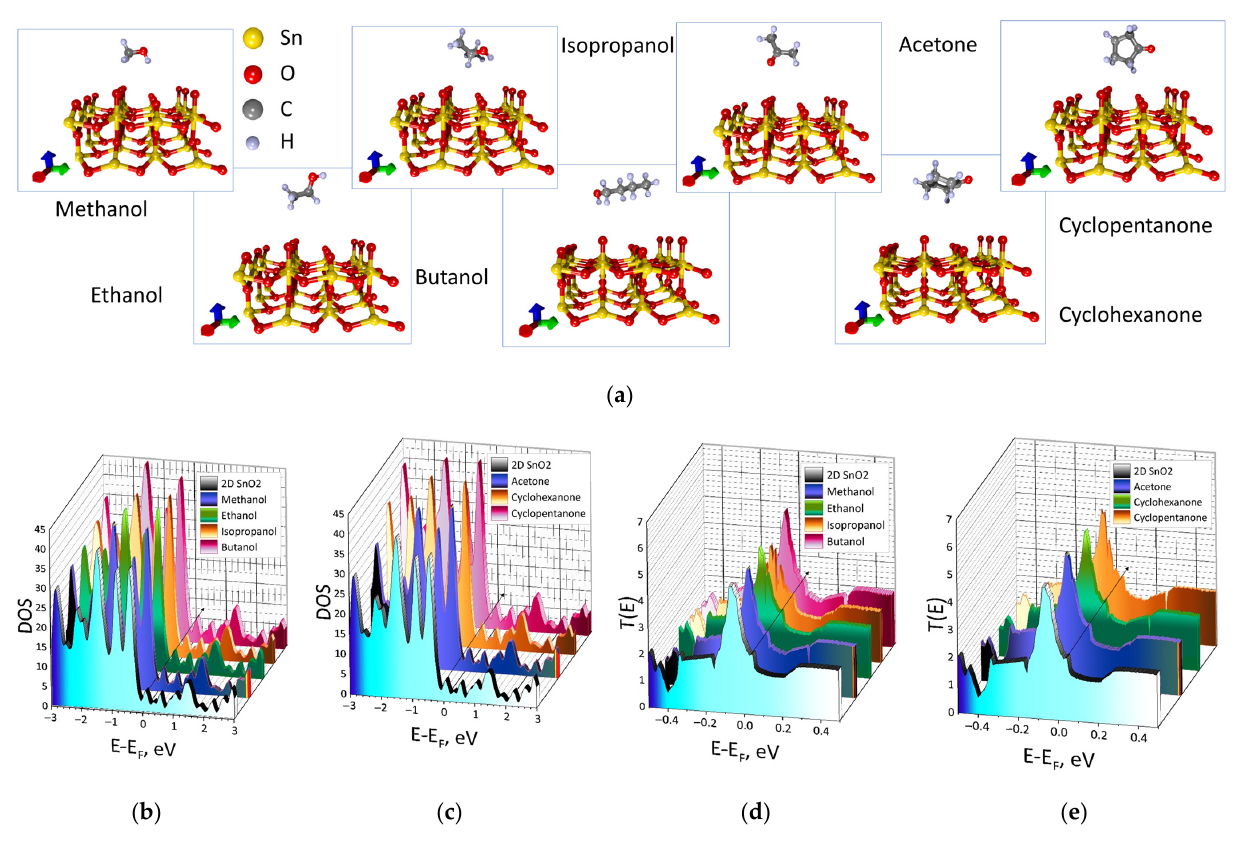
Figure 2. The supercells of quasi ‐ 2D SnO 2 films with landed alcohols and ketones ( a ) and their electronic characteristics: the DOS plots ( b , c ) and the electron transmission functions ( d , e ) (black arrows indicate the positions of the Fermi level after planting of various analytes).